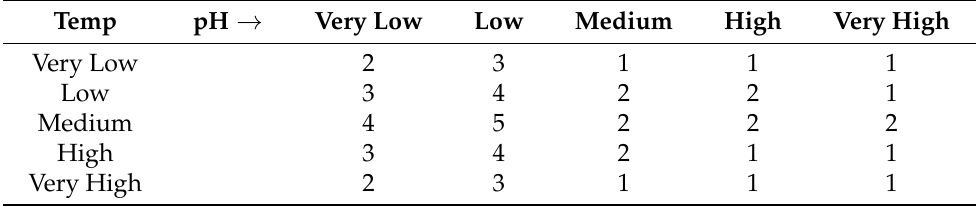
Table 1. Base rule output (enzyme activity: 1 = Very Low, 2 = Low, 3 = Medium, 4 = High, 5 = Very